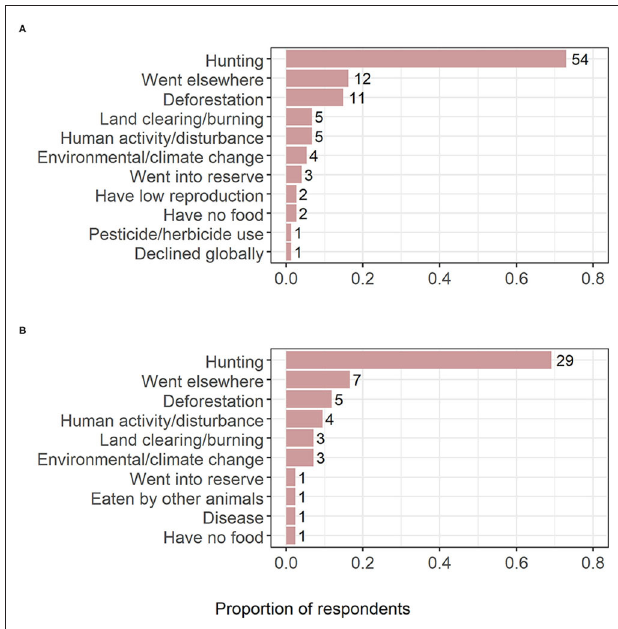
FIGURE 4 | (A) Interviewees’ perceptions of the reasons for local wildlife decline ( n = 76). (B) Interviewees’ perceptions of the reasons for local wildlife extirpation ( n =